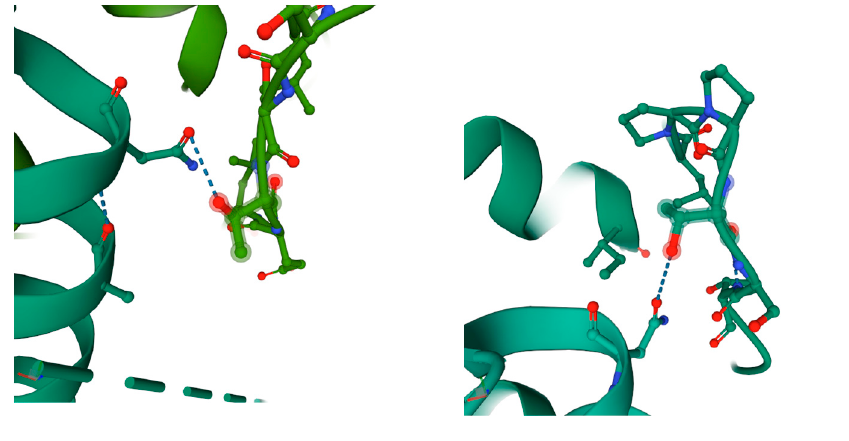
Figure 2. Proposed interaction sites between amino acid residues in human Apc1 and human Cdc20. ( A ) The modeled interactions in the absence of the mitotic checkpoint complex (MCC) between threonine T1239 in Apc1 (displayed in light green) with asparagine N119 in Cdc20 (displayed in dark green). Dashed blue-gray lines denote modeled interactions. ( B ) The modeled interactions in the presence of the mitotic checkpoint complex (MCC) between threonine T1241 in Apc1 (displayed in green on the right) with asparagine N119 in Cdc20 (shown in green on the left). Dashed blue-gray lines denote modeled interactions. Images are from the RCSB PDB (rcsb.org) of PDB ID 6Q6G (without MCC) and PDB ID 6TLJ (with MCC bound) [4,31,32].